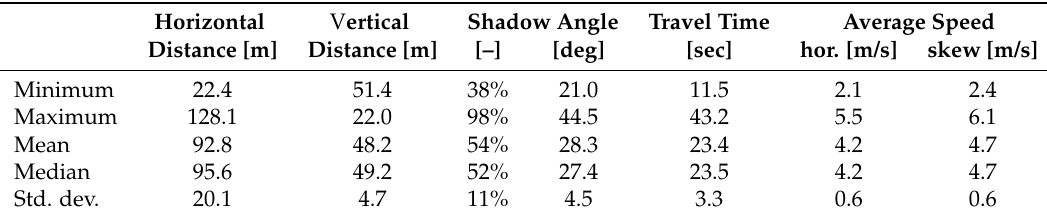
Table 4. Overview of the measurements of full trajectories. Collective results from multiple blocks: runout characteristics calculated based on 102 rockfall tests; travel times and averaged speeds calculated from 73 trajectories.